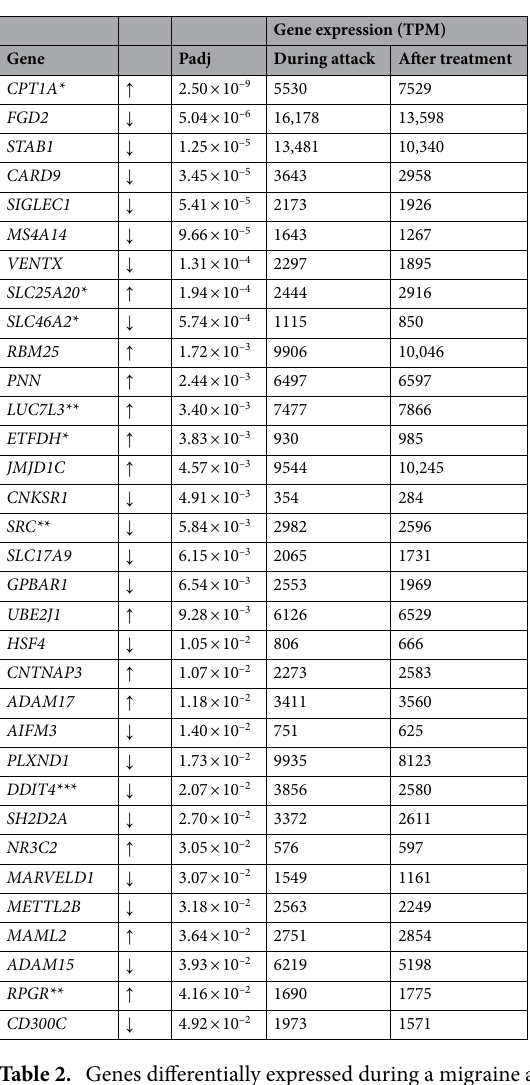
Table 2. Genes differentially expressed during a migraine attack. Results for differential expression analysis (Padj) are given for the comparison during attack vs two hours after treatment. TPM transcripts per million, Padj adjusted p-value. *Genes confirmed by temporal model. **Differentially expressed after cold pressor test. ***Correlates with cortisol levels. In bold the genes also detected to be differentially expressed including the sample taken outside migraine attack (C).